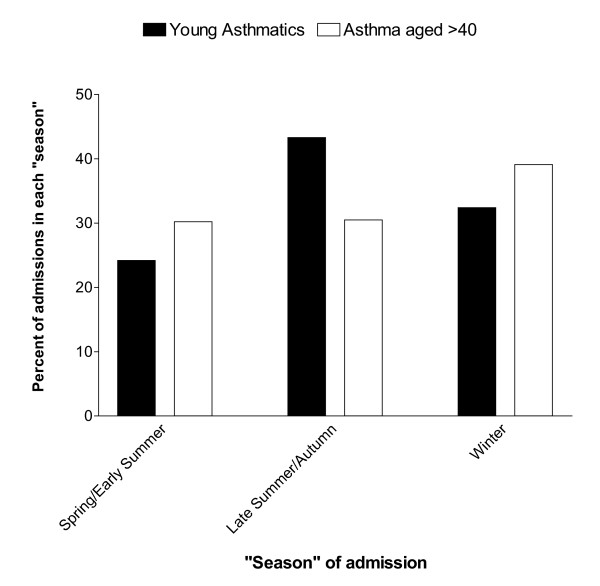
Asthma admissions aggregated by "season", comparing 16–40 age group (black bars) with age >40 (white bars).